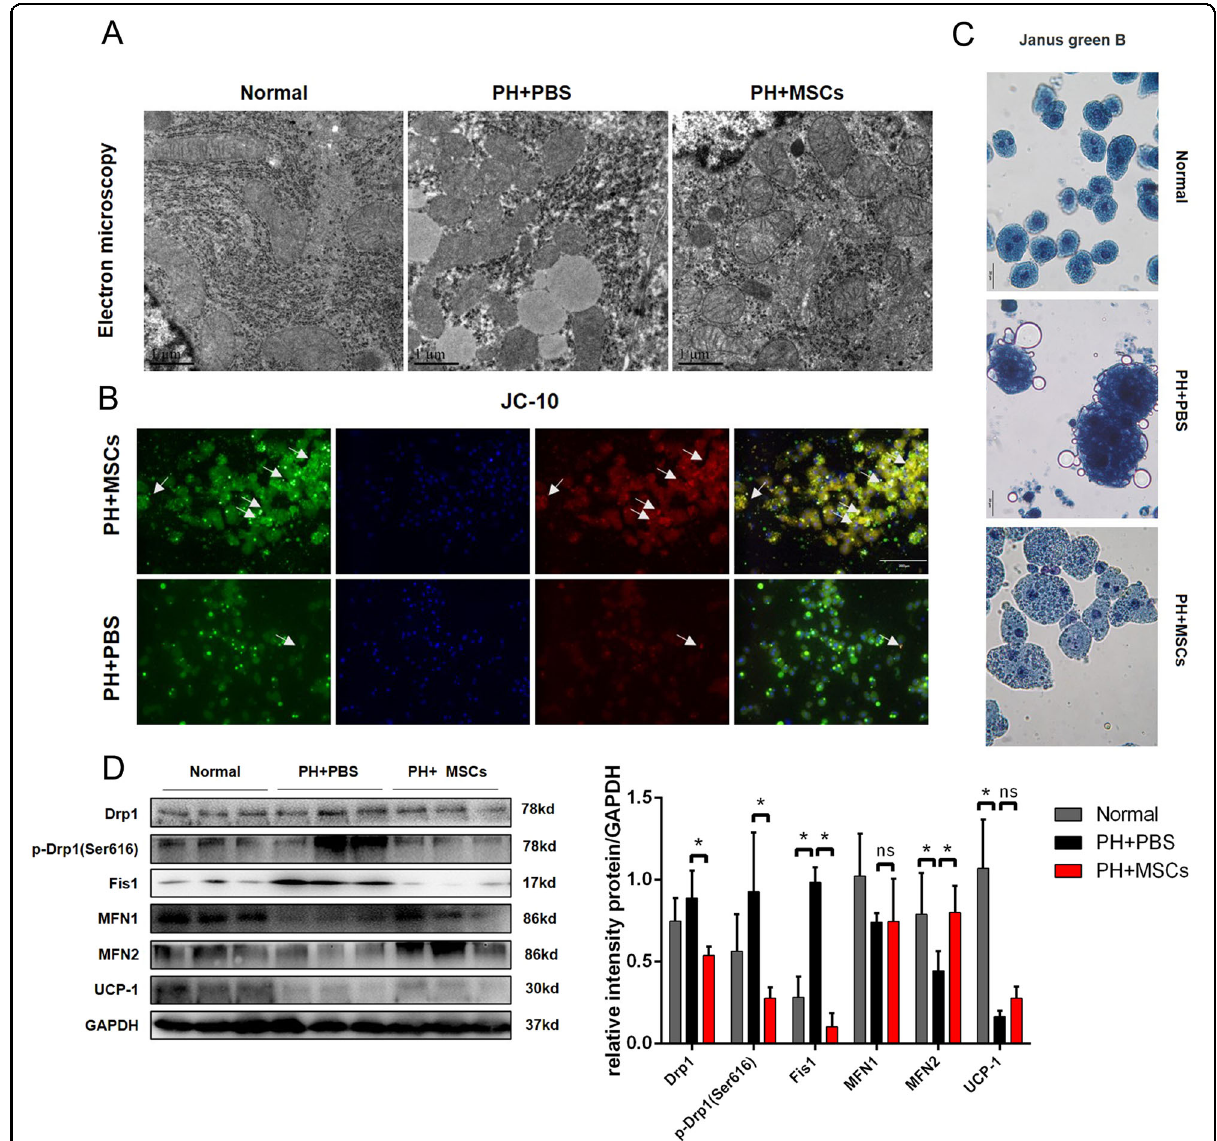
Fig. 3 MSCs transplantation reduces mitochondrial damage in PHLF. A Observation of mitochondria in hepatocytes by transmission electron microscopy. B Observation of mitochondrial membrane potential in hepatocytes by JC-10 staining. C Janus green B staining. D Mitochondrial dynamic protein detection. * P < 0.05. t -test, data are shown as mean standard